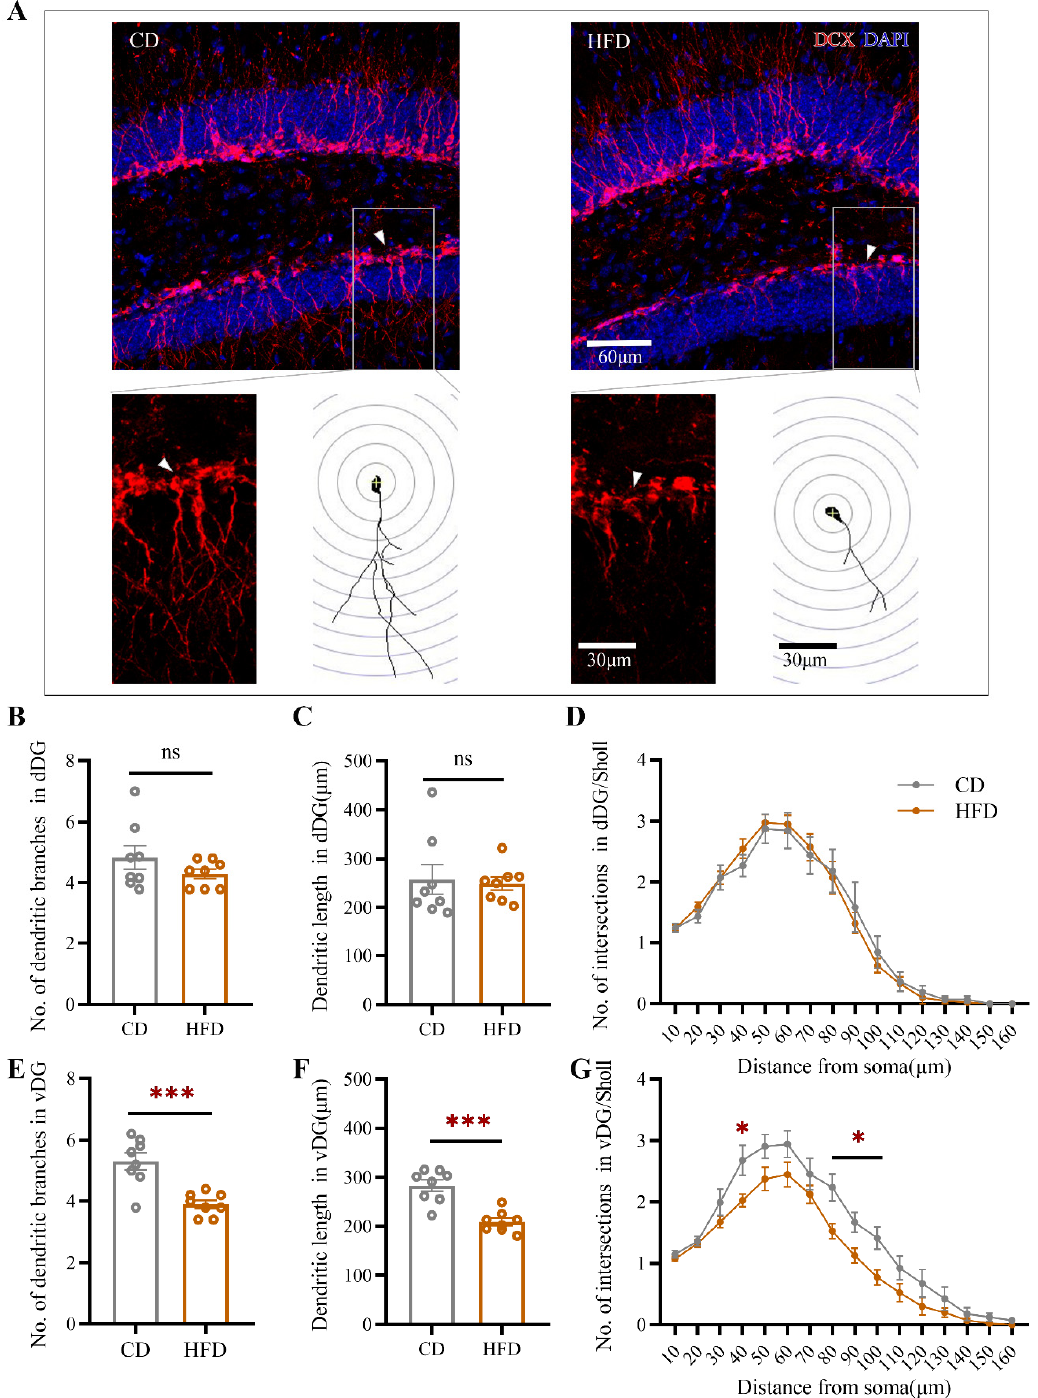
Figure 4. Effect of HFD consumption in adolescence on the morphology of DCX + cells in the mouse hippocampus. ( A ) Fluorescence staining and traces of DCX + cells in the ventral hippocampus of CD- and HFD-fed mice. Red and blue fluorescence represent DCX and DAPI, respectively. The total dendritic length, total number of dendritic branches, and number of intersections (Sholl analysis) of DCX + cells in the dorsal dentate gyrus (dDG) ( B – D ) and vDG ( E – G ) were determined. The data are expressed as the mean ± SEM ( n = 6 mice per group). When HFD group was compared with the CD group, the data were analyzed using Student’s t- test. ns, not significant; * p < 0.05; *** p < 0.001.